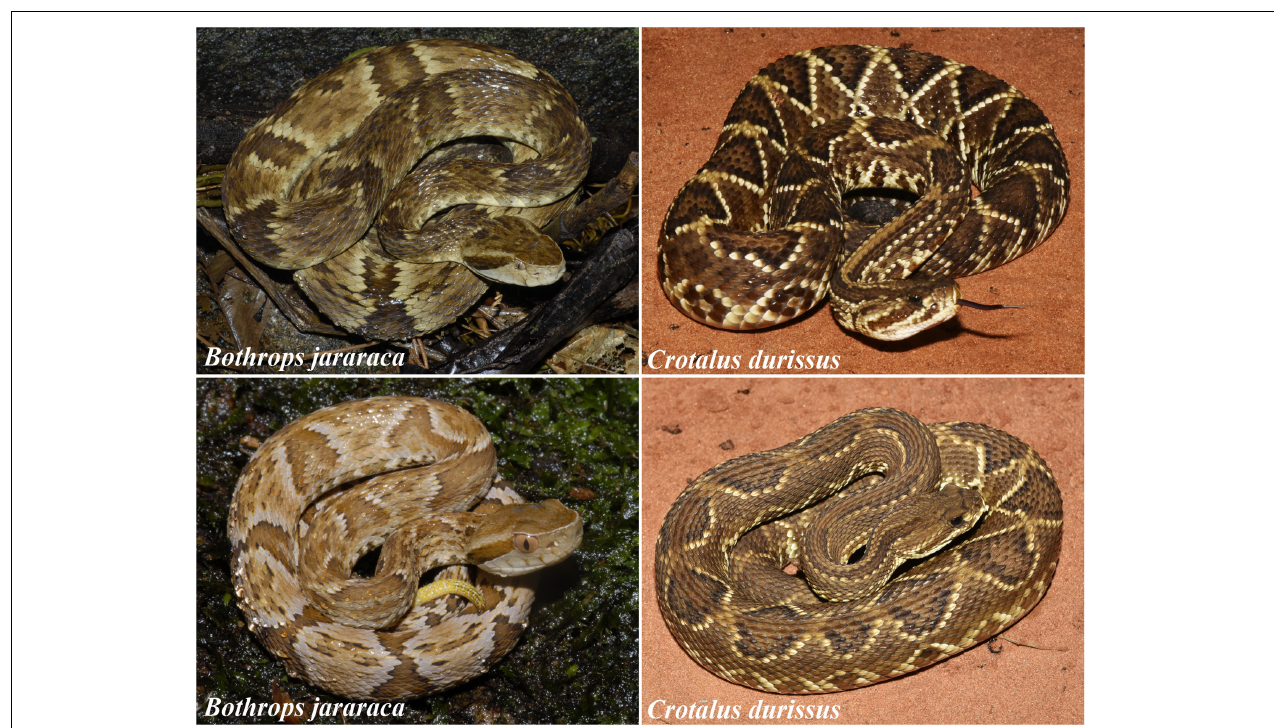
FIGURE 1 | Photographs of adults (upper images) and juveniles (lower images) of Bothrops jararaca and Crotalus durissus . The whitetail observed in the juvenile of B. jararaca (lower left) is used for caudal luring. Photographs: Marcio Roberto Costa